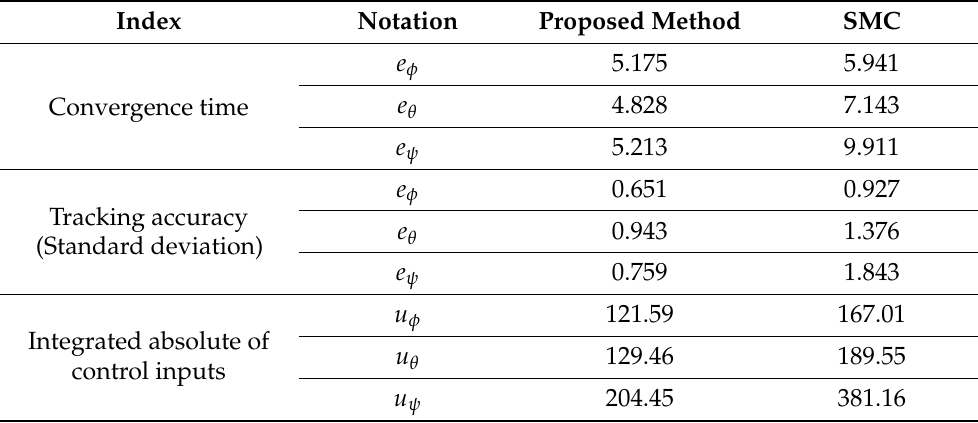
Figure 14. Control inputs using SMC. Table 5. Quantitative analysis between proposed method and SMC in experiments.